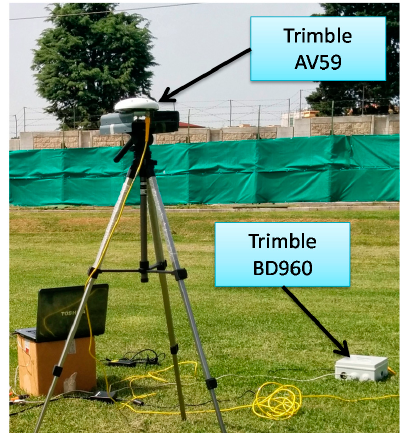
Figure 5. Ground antennas/receivers used as deputy vehicles.